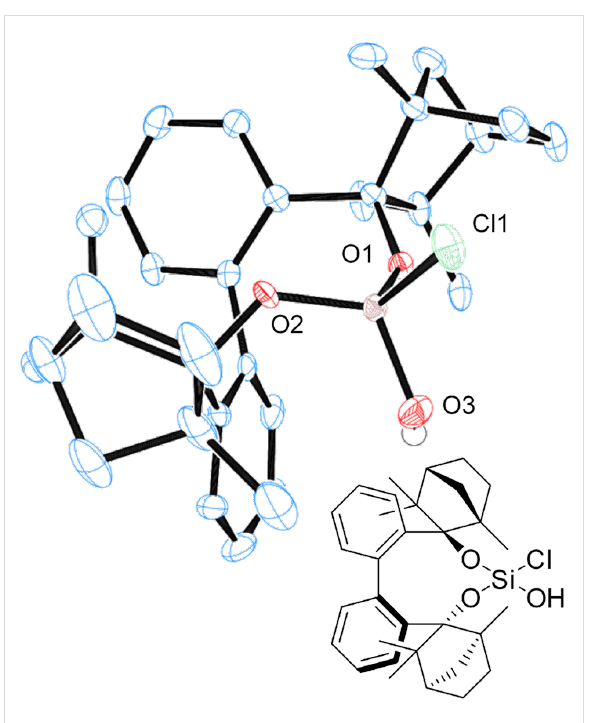
Figure 13: X-ray crystal structure of BIFOXSiCl(OH) ( 8 ). H atoms on the chiral backbone are omitted for clarity issues and the ellipsoids are shown with 65%